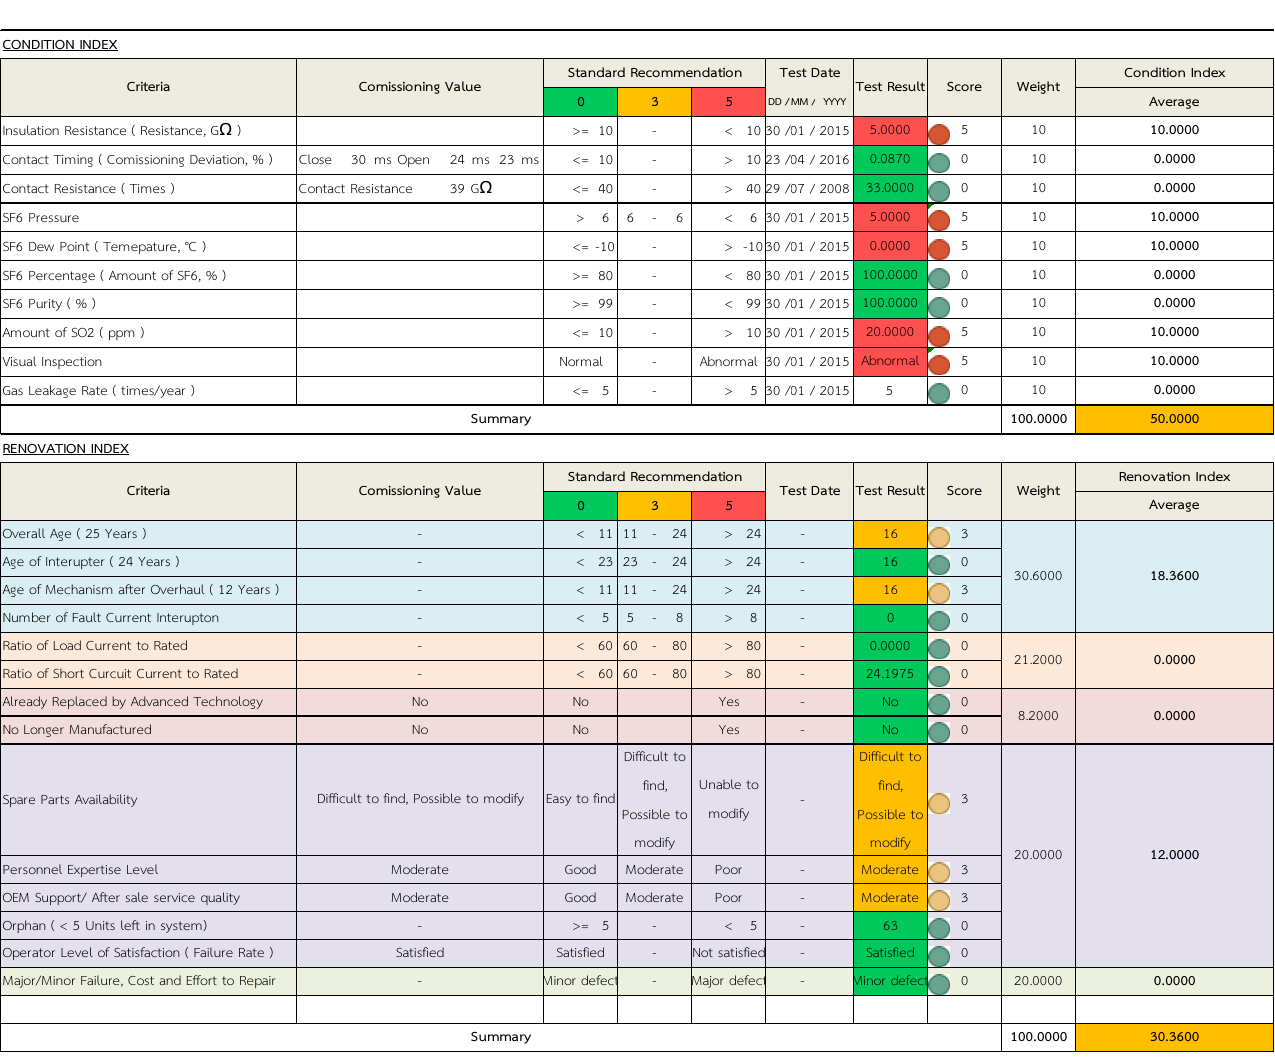
Figure 4. Example of the developed software for evaluating the condition and renovation index with the weighting–scoring technique.